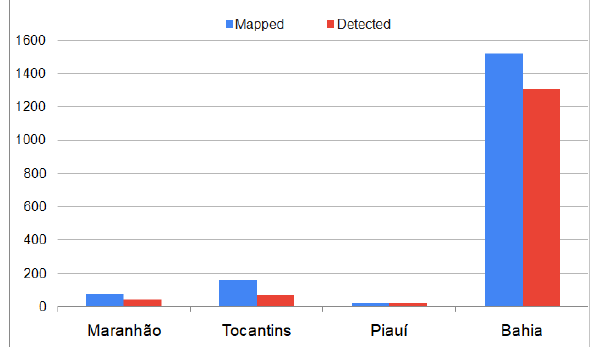
Figure 6. Center pivots detected.